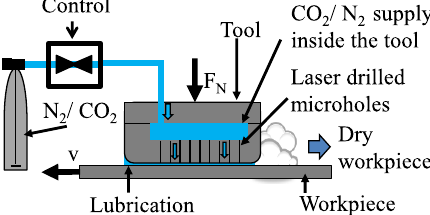
Fig. 12. Experimental setup of fl at strip drawing test using volatile media.